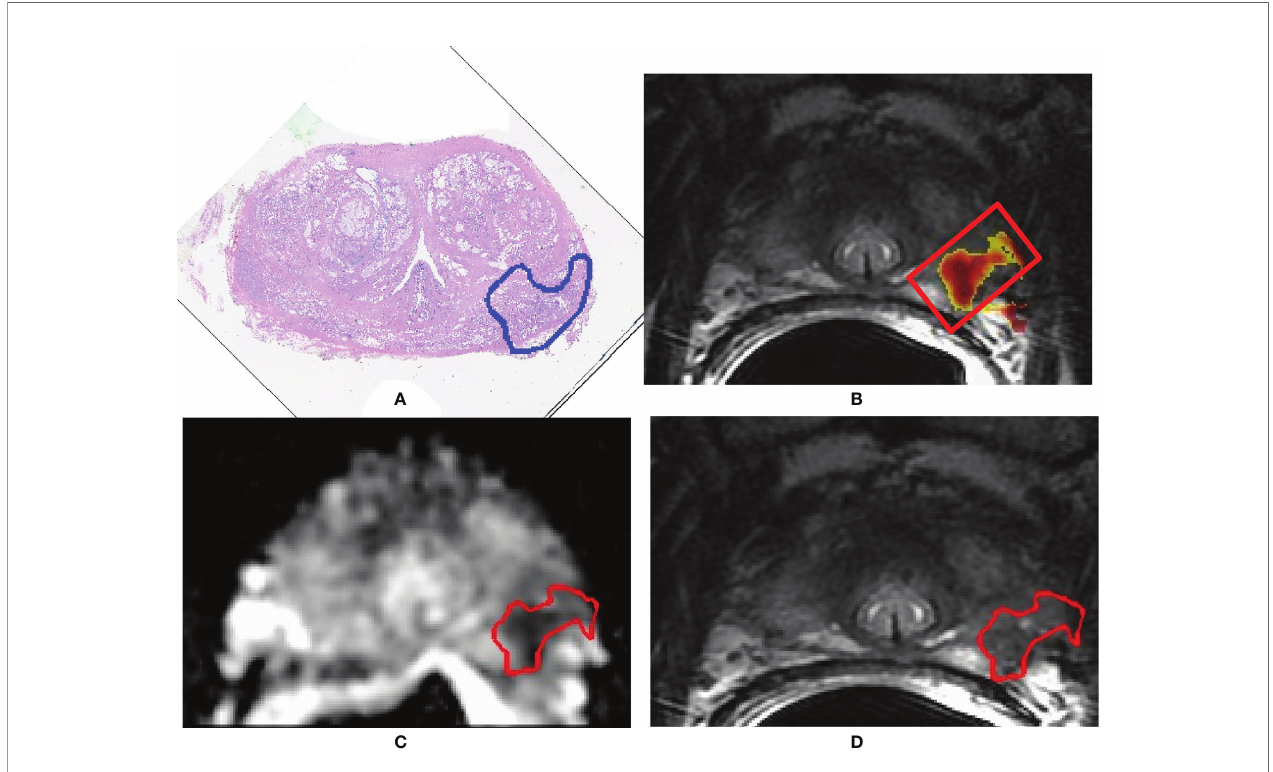
FIGURE 2 | A 71-year-old man with Gleason score 3 + 4 (GG 2) prostate cancer contoured on the whole-mount prostatectomy slice (A) . Findings of the computer- aided diagnosis system were shown to the radiologist superimposed to the T2-weighted (T2w) image (B) . Using pathology results and MR images, the radiologist selected the region of interest containing the whole 3D tumor segmentation (red box in image B ). Texture features were extracted from both the apparent diffusion coef fi cient (ADC) map and the T2w image from voxels belonging to the 3D segmentation of the tumors shown in red in (C, D) . (C) Example of a slice of the segmentation mask of the tumor superimposed to the ADC map; (D) example of a slice of the segmentation mask of the tumor superimposed to the T2w